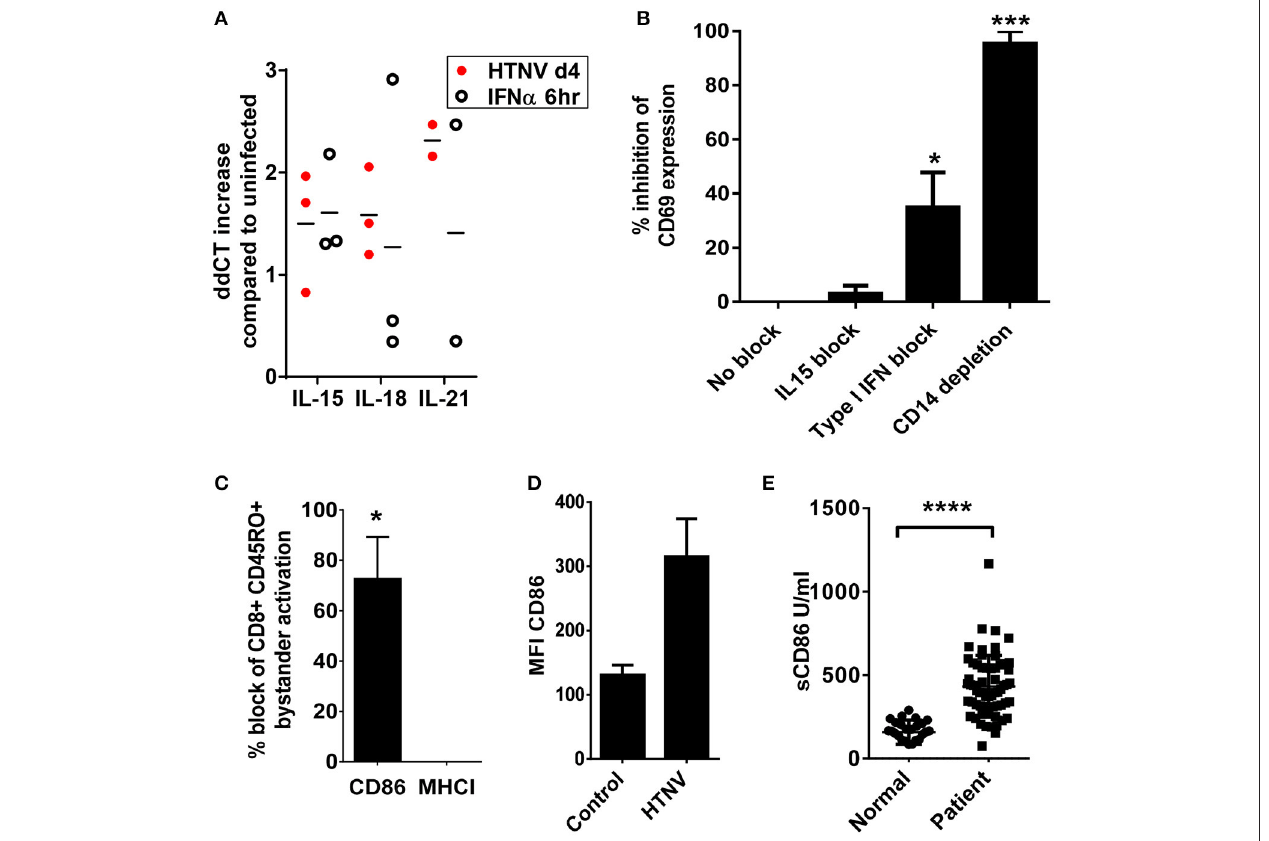
FIGURE 8 | Dependency of hantavirus-induced bystander activation on costimulatory CD86 molecules. (A) Immature DCs were infected with HTNV at a MOI of 1.5 and incubated for 4 days or exposed to IFN- α for 6h at 2,000 U/ml before being harvested. Subsequently, cellular RNA was isolated and the number of indicated cytokine-encoding transcripts quantified by qPCR according to the delta-delta-Ct (ddCt) method. (B) PBMCs treated with anti-IL15 (20 µ g/ml) or anti-IFN- α (20 µ g/ml) and PBMCs depleted of CD14 + cells were exposed to HTNV at a MOI of 1.5 for 4 days before CD69 expression on CD8 + cells was measured by cytofluorimetric analysis. Results are derived from three independent experiments, error bars represent the mean ± SEM (* p < 0.05, *** p < 0.001, 1 way ANOVA test with Bonferroni correction). (C) PBMCs treated with anti-CD86 or anti-MHC (both 10 µ g/ml) were exposed to HTNV at a MOI of 1.5 for 4 days before CD69 expression on CD8 + CD45RO + cells was determined by cytofluorimetric analysis. Error bars represent the mean ± SEM (* P < 0.05, Student’s t-test). (D) PBMC infected with MOI 1.5 of TULV or HTNV were analyzed 3 days post infection for the expression of CD86 on the surface of CD14 + cells. (E) Sera from normal healthy individuals or convalescent hantavirus-infected patients were tested by ELISA for levels of sCD86. Error bars represent the mean ± SD (**** p < 0.0001, paired Student’s t-test).